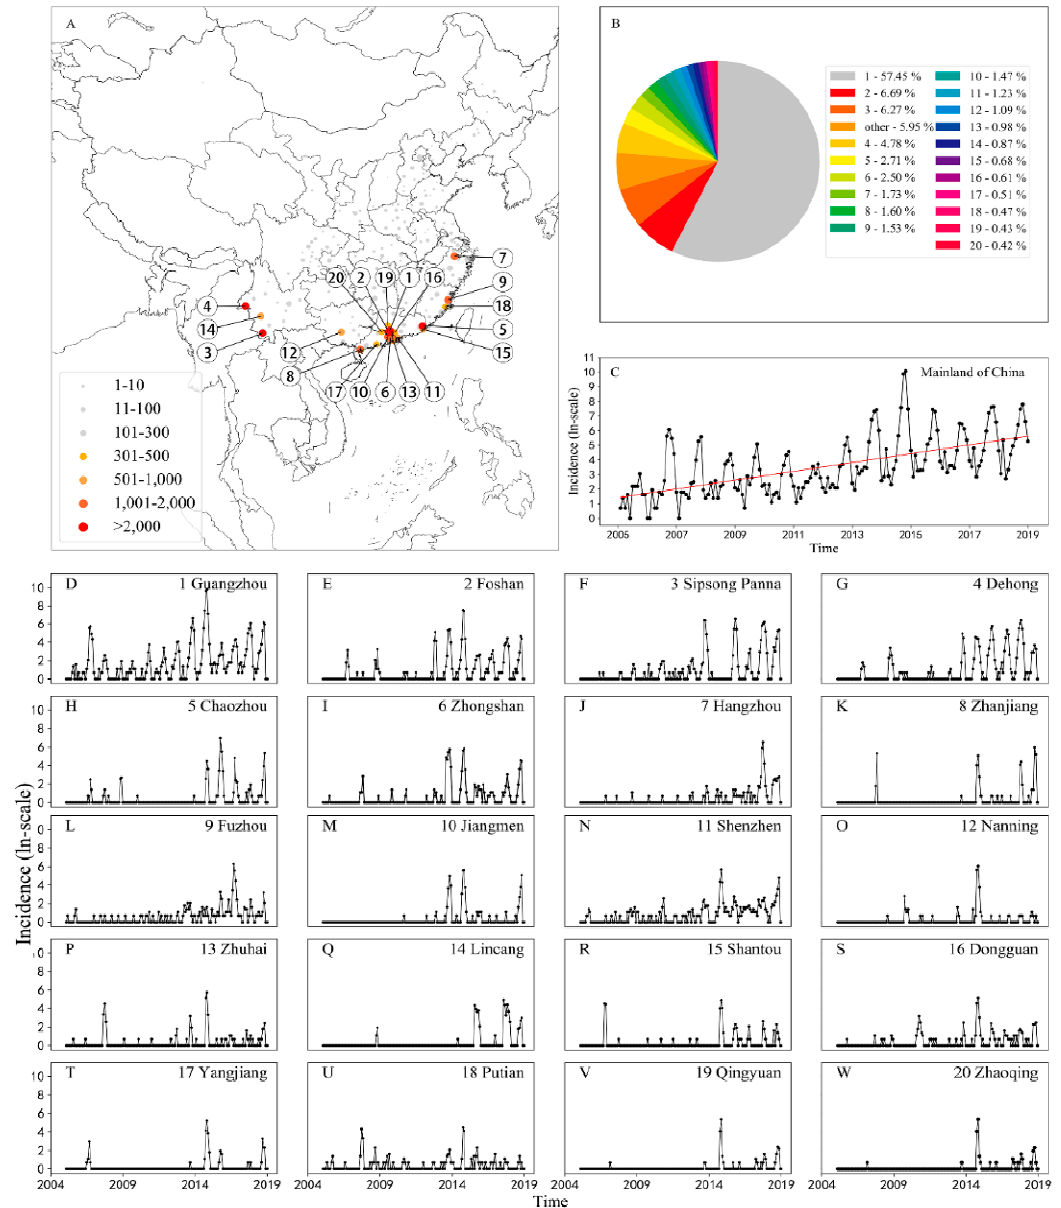
Figure 1. Spatial and temporal distribution of dengue cases in 20 selected cities in mainland China from 2005 to 2018. ( A ) Distribution of dengue cases in China (case numbers are distinguished by color and size according to the magnitude in each city), ( B ) the proportion of cases in each city, ( C ) time series of dengue incidence in mainland China (on the logarithmic scale), and ( D – W ) time series of dengue cases in the top 20 cities with the highest dengue incidence (on the logarithmic scale). Based on the Chinese provincial administrative districts public map downloaded from the National Geomatics Center of China (NGCC) website, this figure was produced using the matplotlib basemap toolkit (https://matplotlib.org/basemap/), which is a library for plotting data on maps in Python.